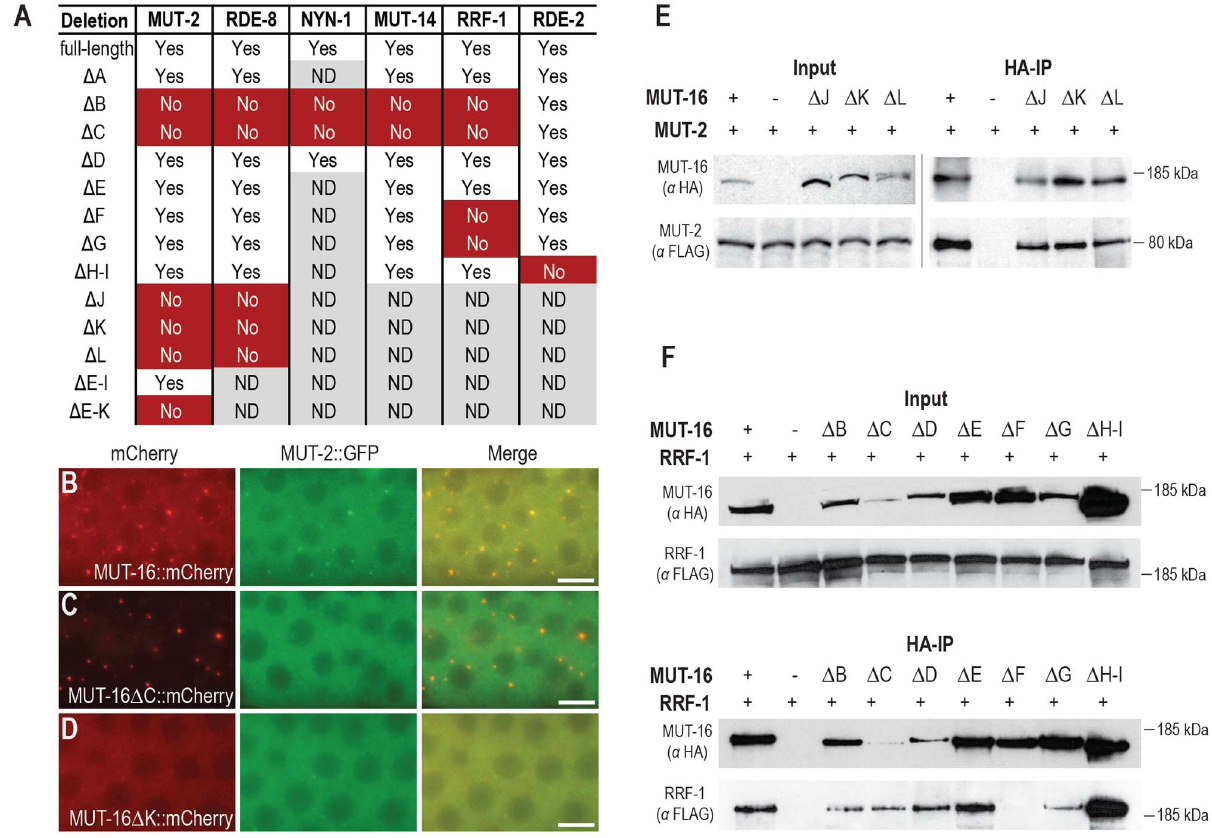
Fig 4. Distinct regions of MUT-16 recruit each of the other Mutator proteins. (A) Table indicates whether mut-16 deletions disrupt MUT-2, RDE-8, NYN-1, MUT-14, RRF-1, and RDE-2 foci. Yes indicates foci present in the majority of animals, No indicates foci absent or severely disrupted, and ND indicates that strain was not constructed or scored. (B-D) MUT-16::mCherry and MUT-2::GFP expression and localization for control strain (B) or when Δ C (C) or Δ K (D) deletions have been introduced into the mut-16 :: mCherry strain. Scale bars, 5 μ m. (E) Immunoprecipitation and western blot of MUT-16::mCherry::2xHA (expected sizes between 135–141 kD for MUT-16 deletions and 148 kD for MUT-16 full length) and MUT-2::GFP::3xFLAG (83 kD). Left panels are total lysate from strains indicated above, and right panels are following HA immunoprecipitation. (F) Immunoprecipitation and western blot of MUT-16::mCherry::2xHA (expected sizes between 132–142 kD for MUT-16 deletions and 148 kD for MUT-16 full length) and GFP::3xFLAG::RRF-1 (219 kD). Top two panels are total lysate from strains indicated above, and bottom two panels are following HA immunoprecipitation. The equivalent of ~0.5% of starting material for the input fractions and ~20% of starting material for the IP fractions were loaded onto the gels.